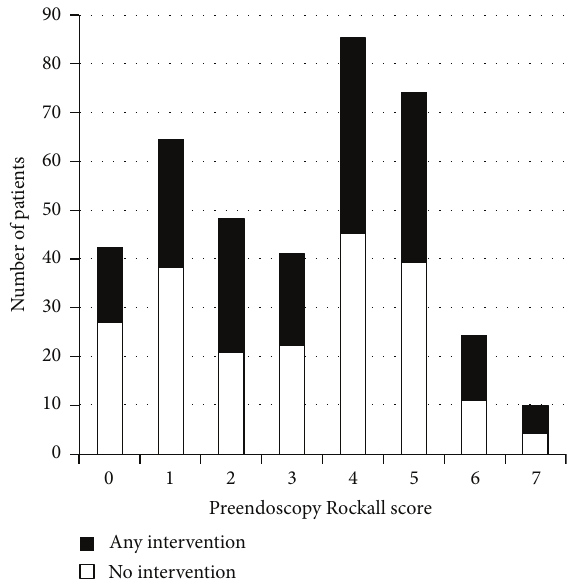
Figure 2: Preendoscopy Rockall score (PERS) for 388 consecutive patients admitted with upper gastrointestinal haemorrhage over 5 years (2006–2011). The need for any intervention (endoscopic, surgical, or blood transfusion) is shown. The PERS range of the study population was 0–7 with an average of 3.11: 46.7% of patients required intervention.